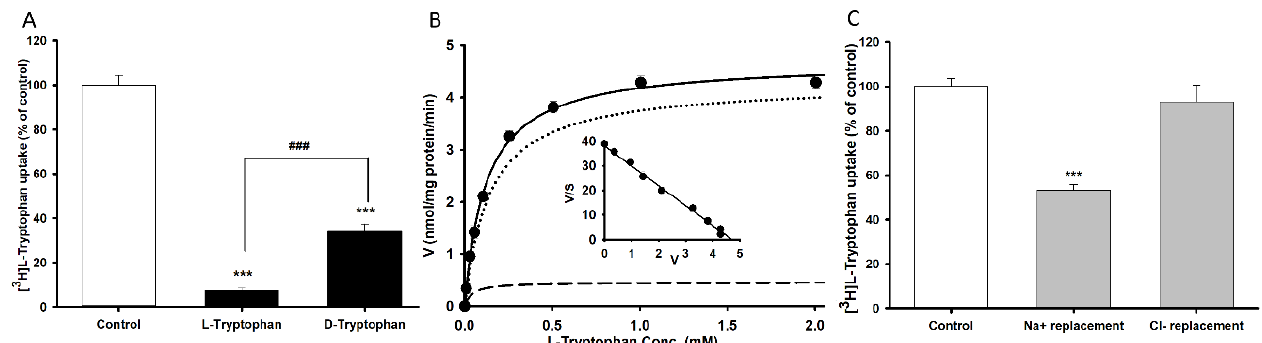
Figure 1. Stereospecificity, concentration, and ion dependency of [ 3 H] L -tryptophan uptake by tryptophan in brain capillary endothelial (TR-BBB) cell lines at 37 °C for 5 min at pH 7.4. ( A ) [ 3 H] L -Tryptophan uptake in the presence of 2 mM unlabeled